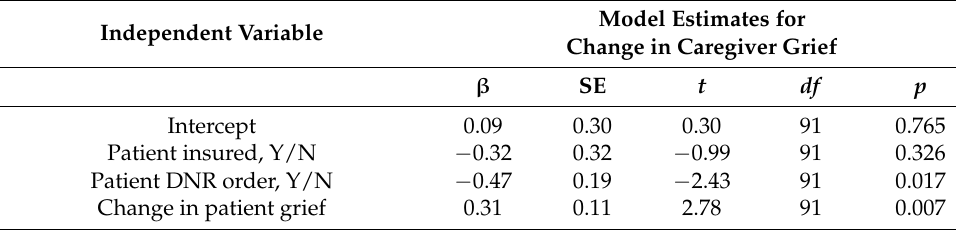
Model Estimates